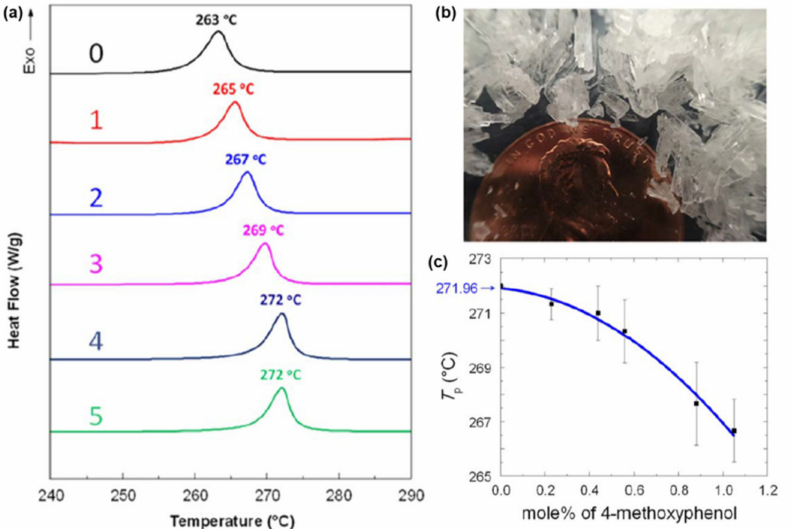
Figure 61. ( a ) DSC thermograms showing the change in the polymerization temperature of PH-a after successive recrystallization processes. ( b ) digital image of crystals of PH-a after all recrystallization processes and ( c ) variation of T p as a function of the concentration (C) of 4-methoxyphenol, as the initiator (a quantitative relationship, T o = 271.96 − 0.78C − 4.21C 2 is obtained) [121]. Copyright 2017. Reproduced with permission from Wiley Periodicals,